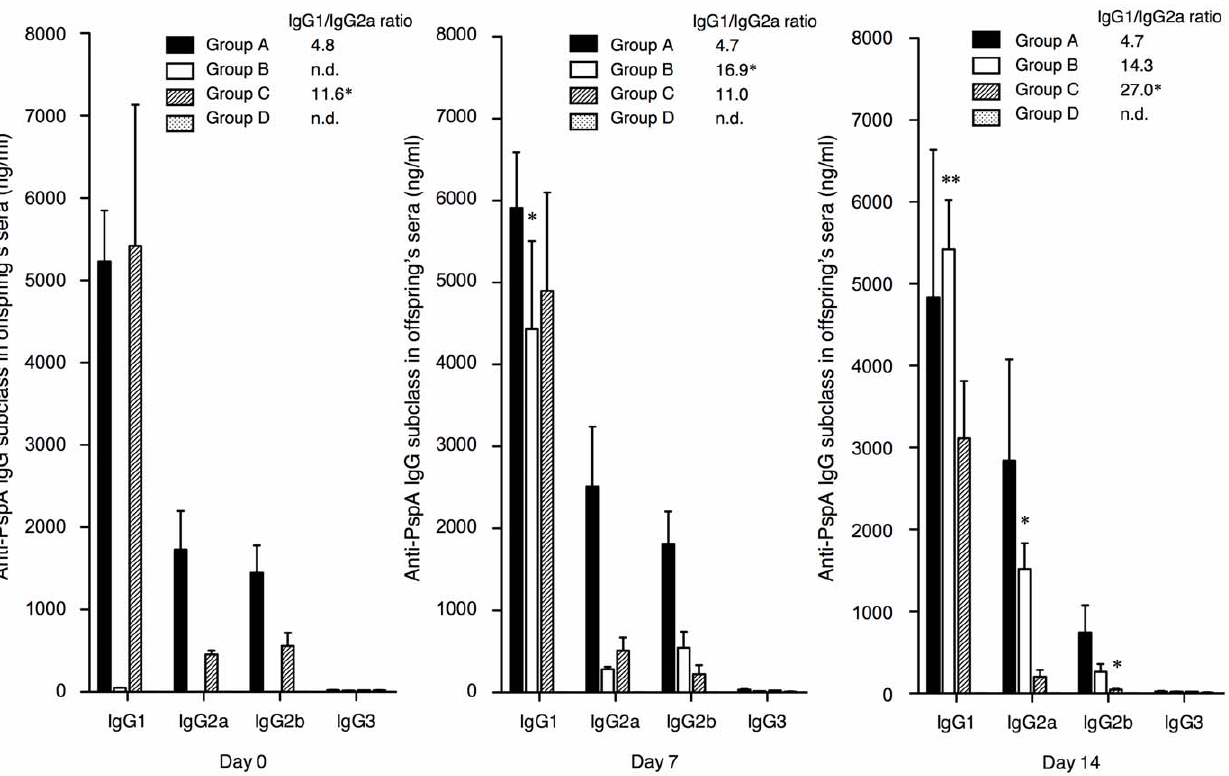
Figure 4. Anti-PspA specific IgG subclasses in sera of offspring. The levels of anti-PspA specific IgG subclasses in offspring’s sera were determined by PspA-specific ELISA on day 0, 7, and 14 after birth. Group A (n=26), B (n=22), C (n=27), and D (n=18) mice were the same mice as described in figure 3. The values shown are the mean 6 S.E. concentrations (ng/ml). The mean values of IgG1/IgG2a ratio were also shown. * p , 0.05 and ** p , 0.01 are for comparisons with offspring in Group D for PspA-specific IgG subclasses or with offspring on day 0 for the IgG1/IgG2a ratio by ANOVA test with Dunn’s multiple comparison test.